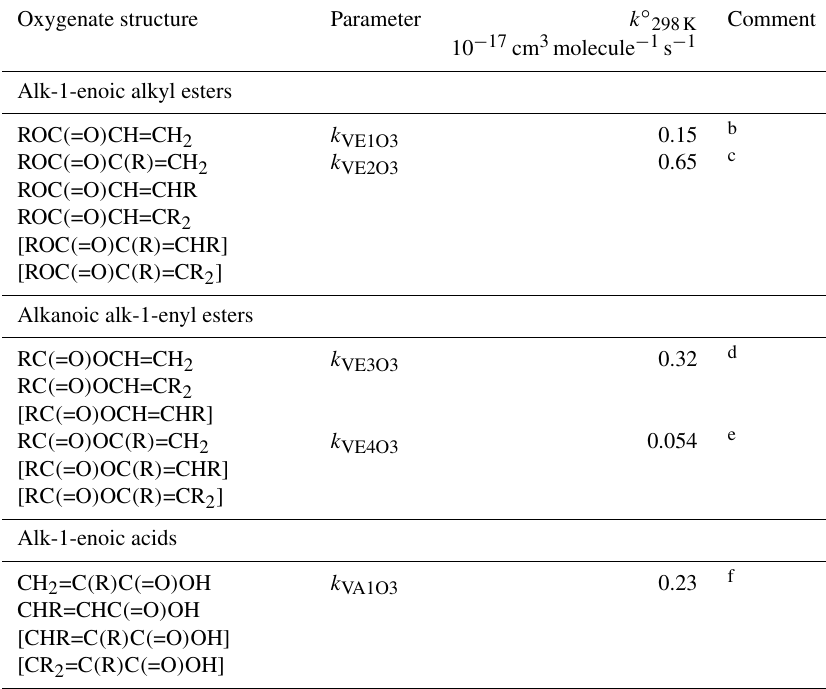
Table 7. Reference rate coefficients for O 3 addition to acyclic vinylic esters and acids a